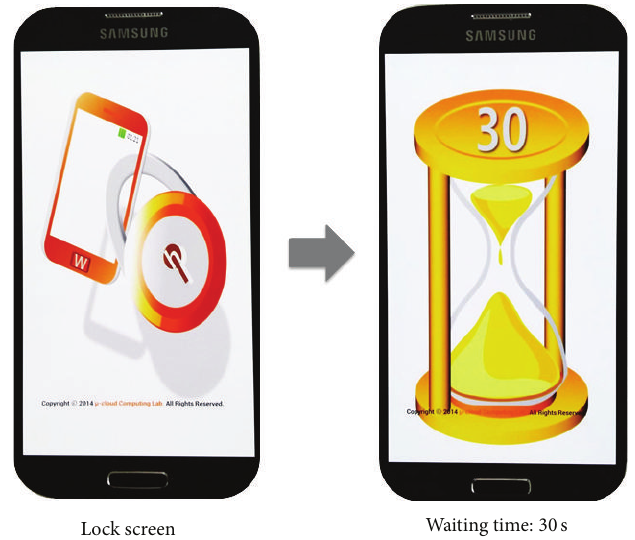
Figure 6: Waiting visualization for nonauthorizing access of